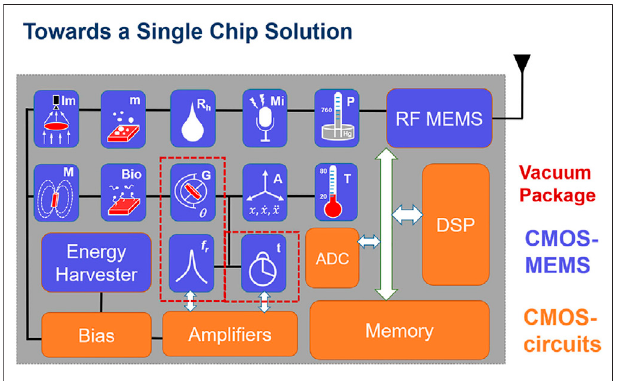
FIGURE 1 | Monolithic integration of a smart sensor system using a CMOS